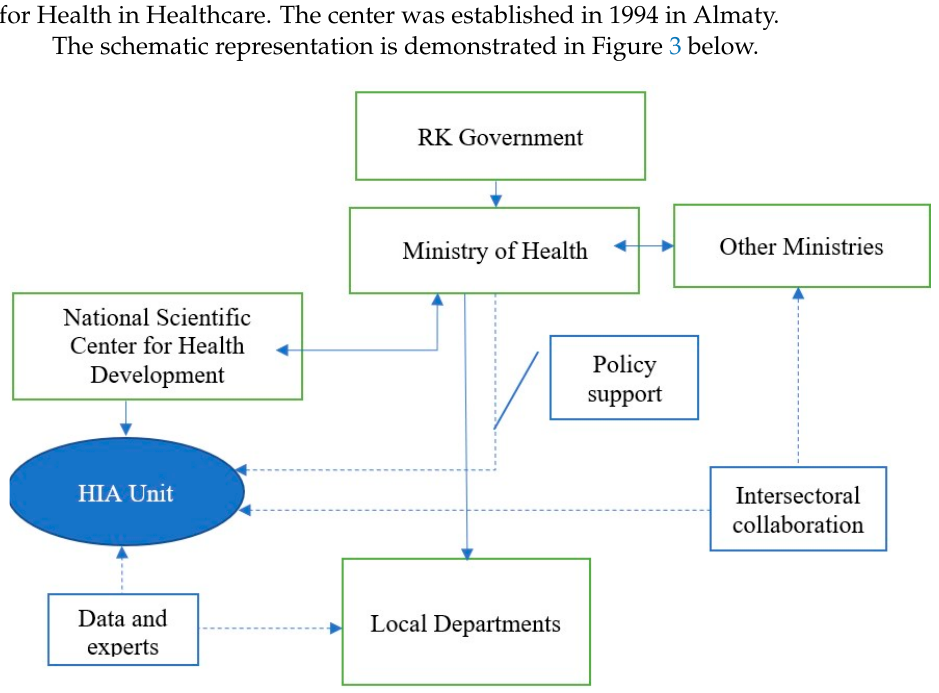
Figure 3. Model of HIA implementation.